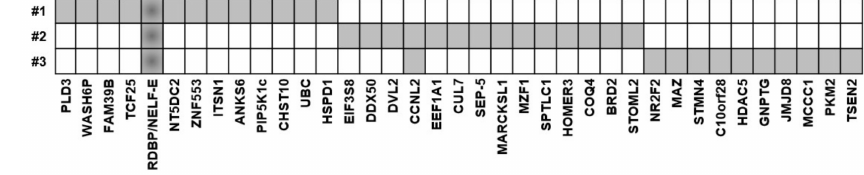
Figure 1. Positive autoantigens in the three screening sera from patients with sarcoidosis.